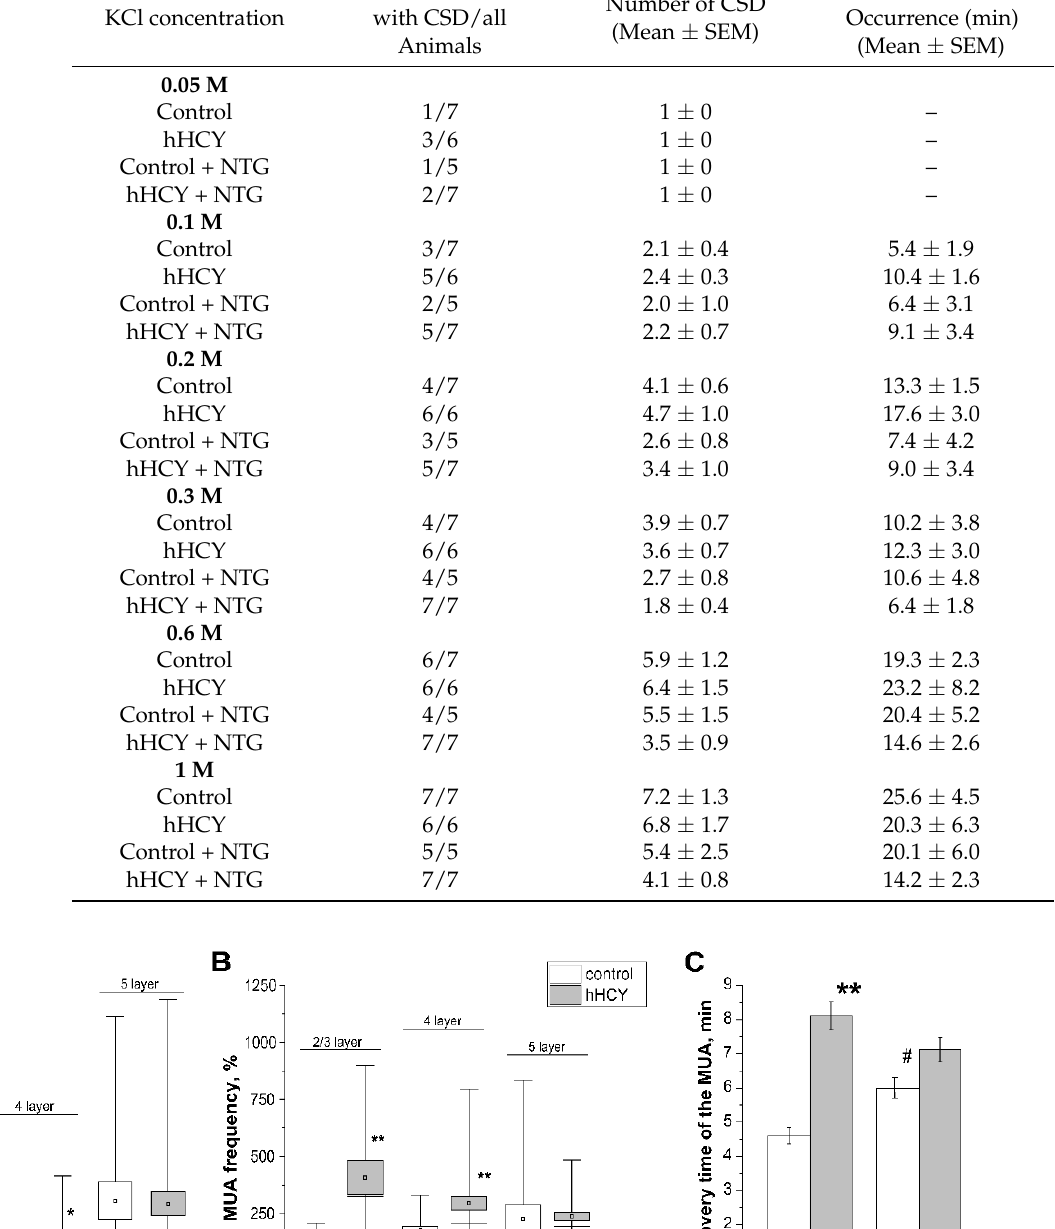
Table 2. Effect of NTG on parameters of CSD in rats from control and hHCY groups.